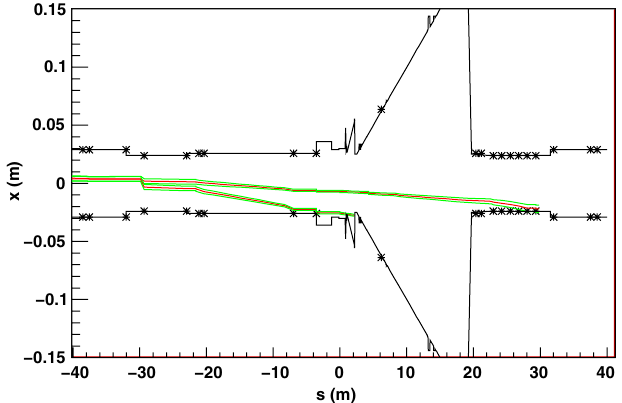
FIG. 9. (Color) The range of the corrector on Q1, MCBXH settings, which are dangerous for the LHCb beam pipe and interaction region magnets for beam 1 and excess current in the magnet. The effects of injection jitter and 3 (cid:3) beam envelope scraping have been included. In this plot, the beam centroid is shown in red and the beam envelope is shown in green.